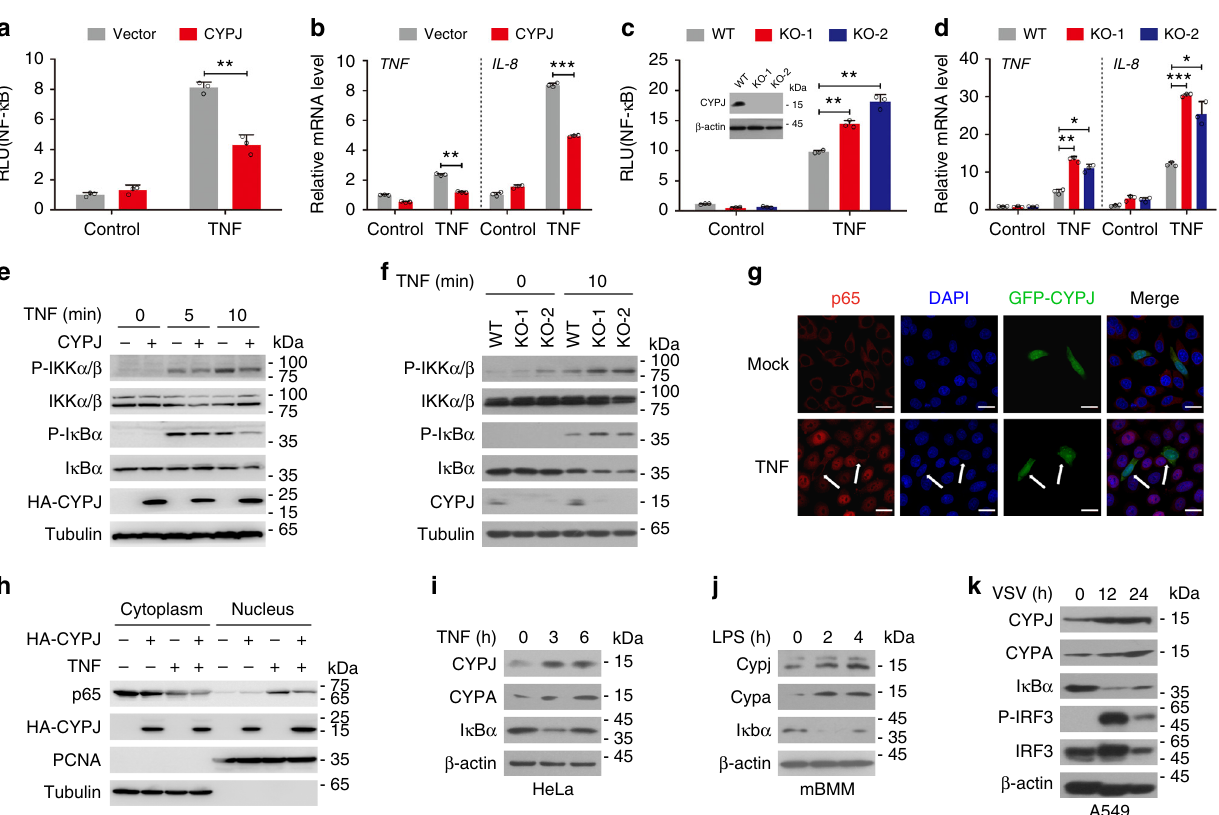
Fig. 1 CYPJ negatively regulates the NF- κ B signal pathway. a CYPJ inhibits TNF-induced activation of the NF- κ B reporter in 293T cells ( N = 3). b CYPJ inhibits TNF-induced transcription of TNF and IL-8 in 293T cells ( N = 3). c CRISPR-Cas9-mediated CYPJ de fi ciency (inset) enhances TNF-induced activation of the NF- κ B reporter in 293T cells ( N = 3). d CYPJ knockout enhances TNF-induced transcription of TNF and IL-8 in 293T cells ( N = 3). e 293T cells were transfected with a control or HA-CYPJ plasmid and were treated with TNF for different times. Phosphorylation of the indicated proteins was detected. f WT and CYPJ-de fi cient 293T cells were treated with or without TNF, and phosphorylation of the indicated proteins was detected. g HeLa cells were transfected with pEGFP-CYPJ (green) and treated with or without TNF (15 ng ml − 1 ) for 15 min. The cells were fi xed, permeabilized, and stained for p65 (red) and 4 ′ 6-diamidino-2-phenylindole (DAPI) (blue), followed by observation by laser confocal fl uorescence microscopy. Scale bars, 20 μ m. The white arrows indicate GFP-CYPJ transfected cells. h 293T cells were transfected with or without HA-CYPJ and stimulated by TNF (15 ng ml − 1 ) for 15 min. The cytoplasmic and nuclear proteins were isolated and detected with the indicated antibodies. i – k Protein levels of CYPJ and CYPA were detected in TNF- treated HeLa cells ( i ), LPS-treated primary mBMM cells ( j ), and VSV-infected A549 cells ( k ). Error bars indicate the standard deviation (S.D.); n.s.